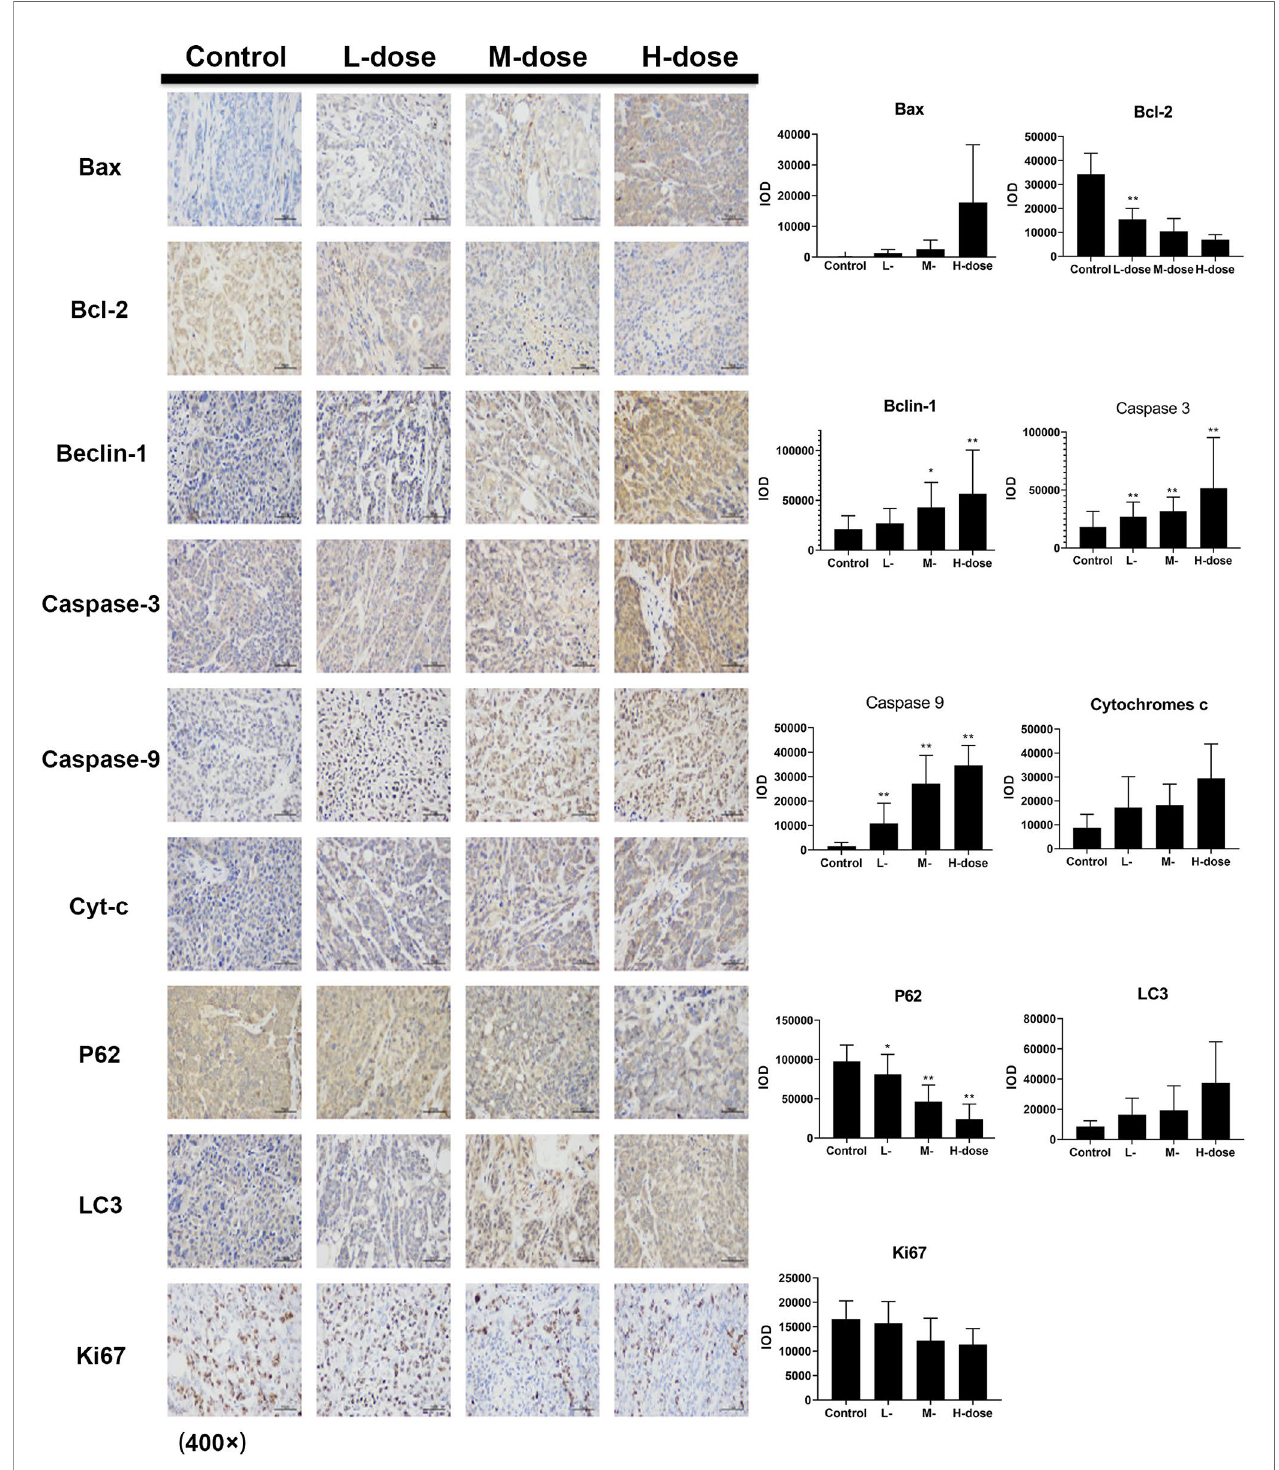
FIGURE 9 | Effect of SDEA on the expression levels of apoptosis- and autophagy-related genes in the issue from HCT116 xenografts (control, po., N.S.; low dose, po., 100 mg/kg/day; medium dose, po., 200 mg/kg/day; and high dose, po., 300 mg/kg/day). (* p < 0.05; ** p < 0.01, vs. control group).